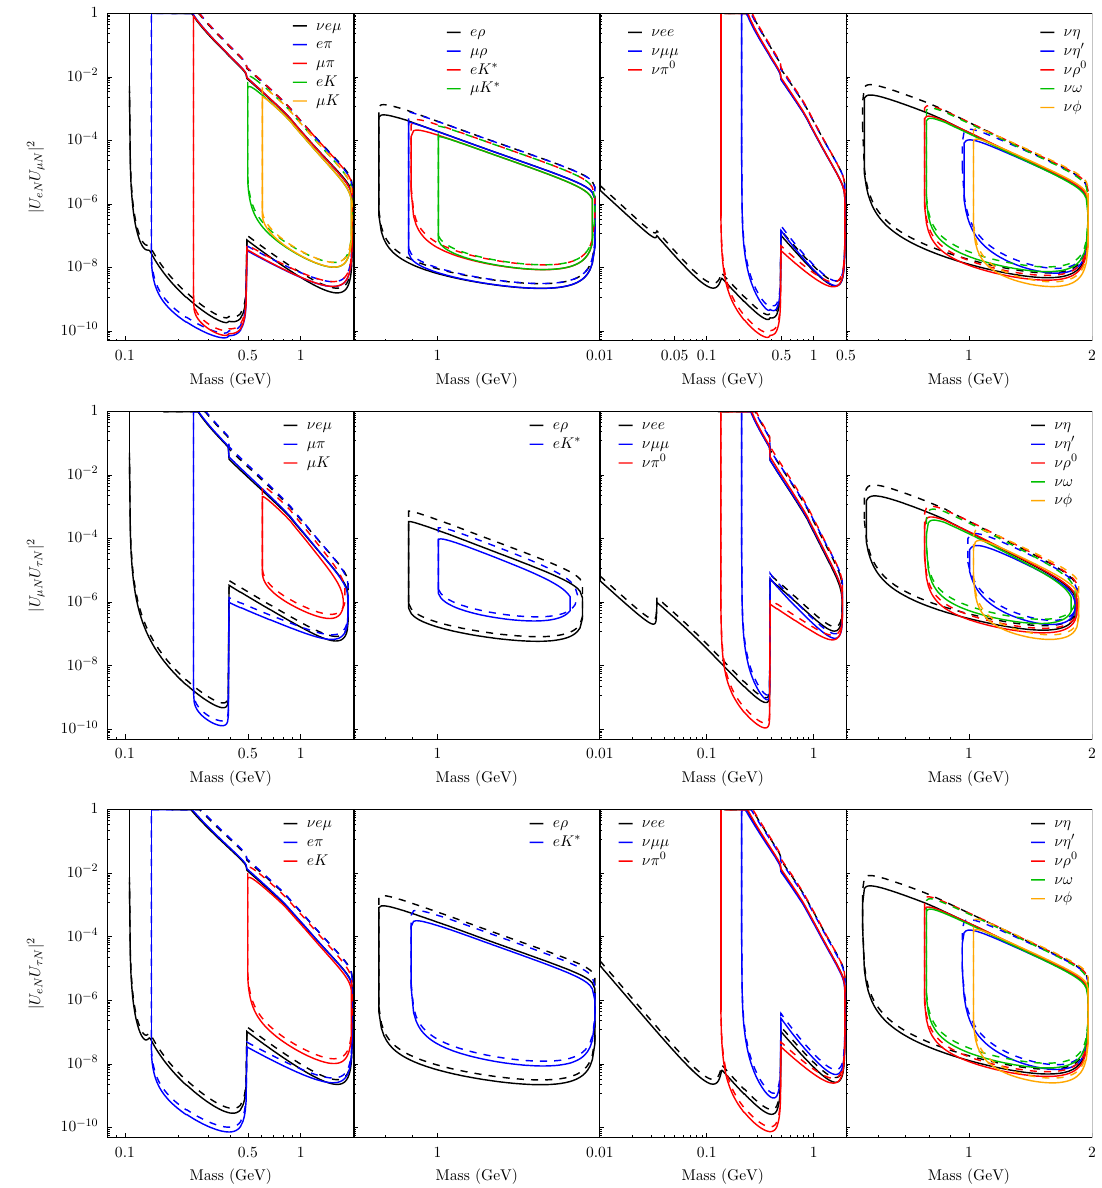
Figure 7 . The 90 % C.L. sensitivity regions to individual channels for two dominant mixings j U (cid:3) U (cid:22)N j (top), j U (cid:3) U (cid:28)N j (middle), and j U (cid:3) U (cid:28)N j (bottom) are presented. All the modes consid- eN (cid:22)N eN ered in this work are shown here, but no background analysis is reported. As before, the solid lines correspond to the analysis with Majorana neutrinos, the dashed lines with Dirac